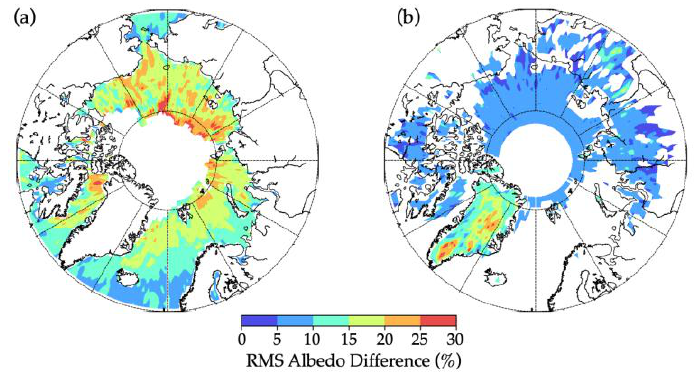
Figure 2. Distribution of regional (1° × 1°) overcast albedo RMS differences for ( a ) ocean and ( b ) snow/ice.